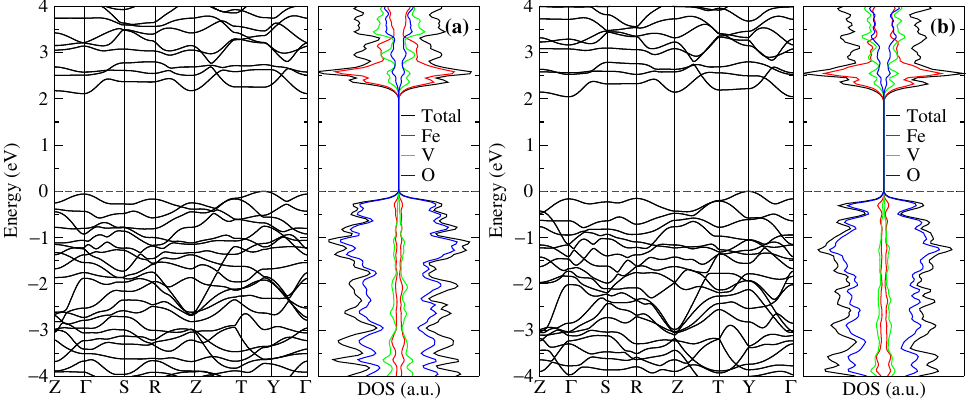
Figure 3. Band structure and electronic density of states at ( a ) ambient pressure and ( b ) 9.6 GPa of FeVO 4 - II